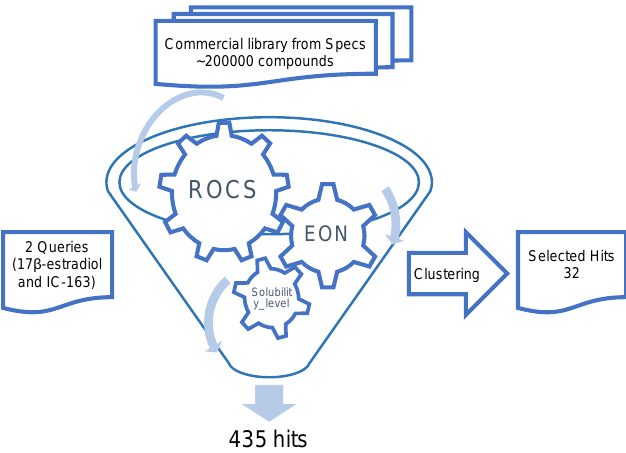
Figure 2. Scheme for three-dimensional virtual screening.